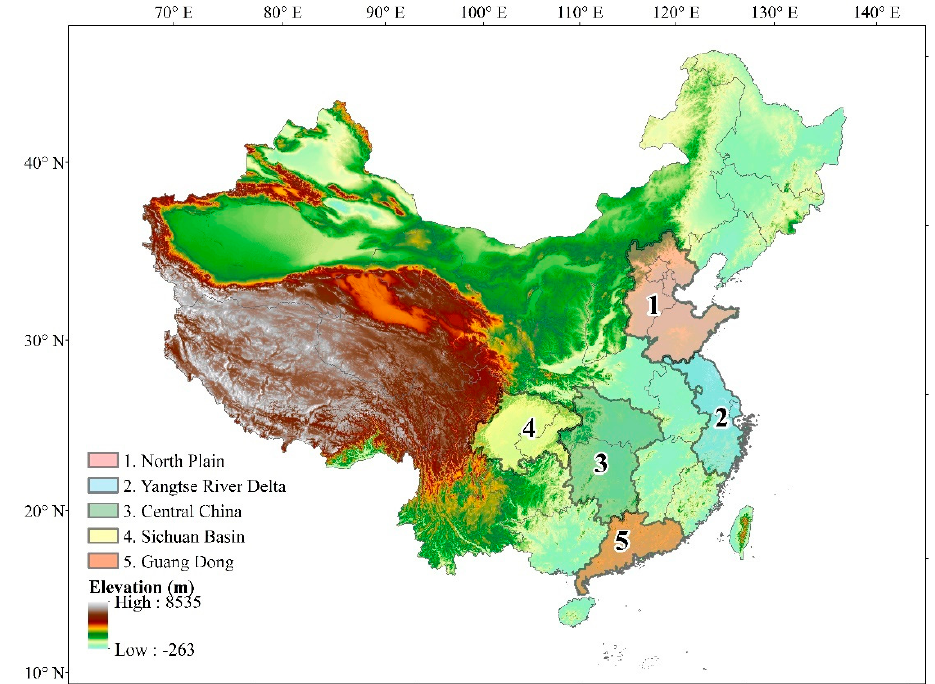
Figure 1. The elevation of study area and location of five typical regions for variation analysis in aerosol optical depth (AOD) and relationships with photosynthetically active radiation (PAR) and net primary productivity (NPP). The five regions are 1. North Plain (NP, including Beijing, Tianjin, Hebei and Shandong Province), 2. Yangtze River Delta (YRD, including Shanghai, Jiangsu and Zhejiang Province), 3. Central China (CC, including Hubei and Hunan Province), 4. Sichuan Basin (SCB, including eastern of Sichuan Province and Chongqing), 5. Guangdong (GD, Guangdong Province).